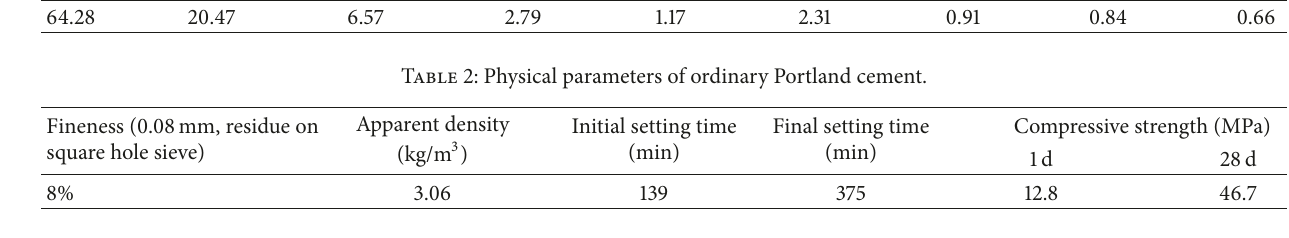
Table 3: Chemical composition of sulphoaluminate cement